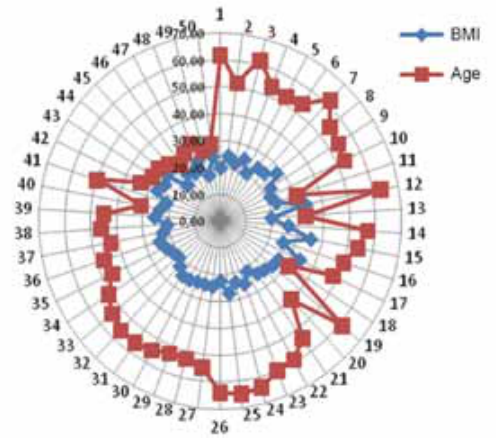
FIGURE 2. Correlation of age and BMI of female respo-